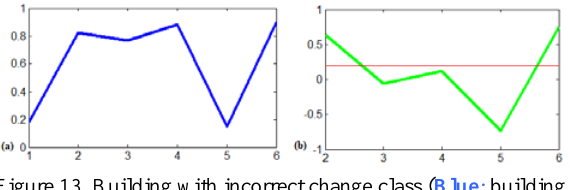
Figure 13. Building with incorrect change class ( Blue : building probably series values; Green: FD; Red: Threshold